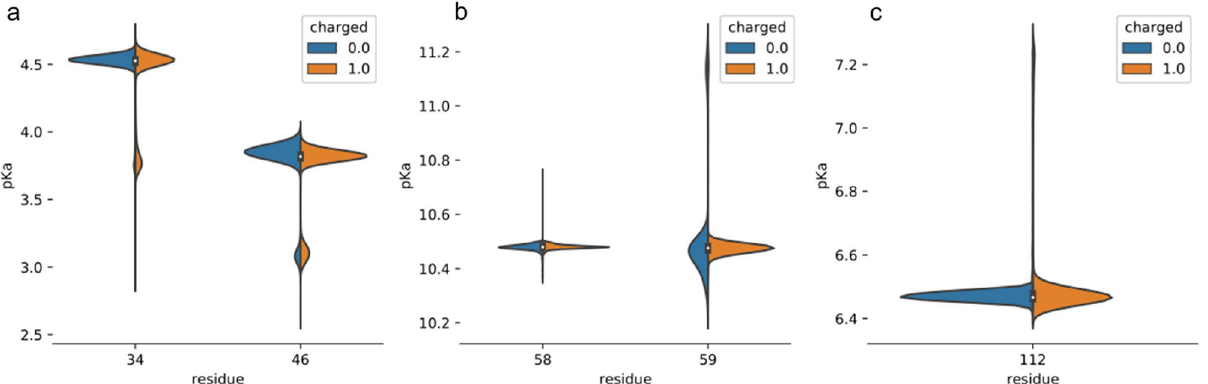
Figure 5. Structure-based pK a values, calculated over the 1 μs molecular dynamics simulations of the destabilase (high salt structure). ( a ) Glu34 and Asp46 residues, ( b ) Lys58 and Lys59 residues, ( c ) His112 residue. Blue and orange violin plots represent uncharged and charged His112 trajectories, respectively. Plot width is proportional to the total share of structures with the respective pKa